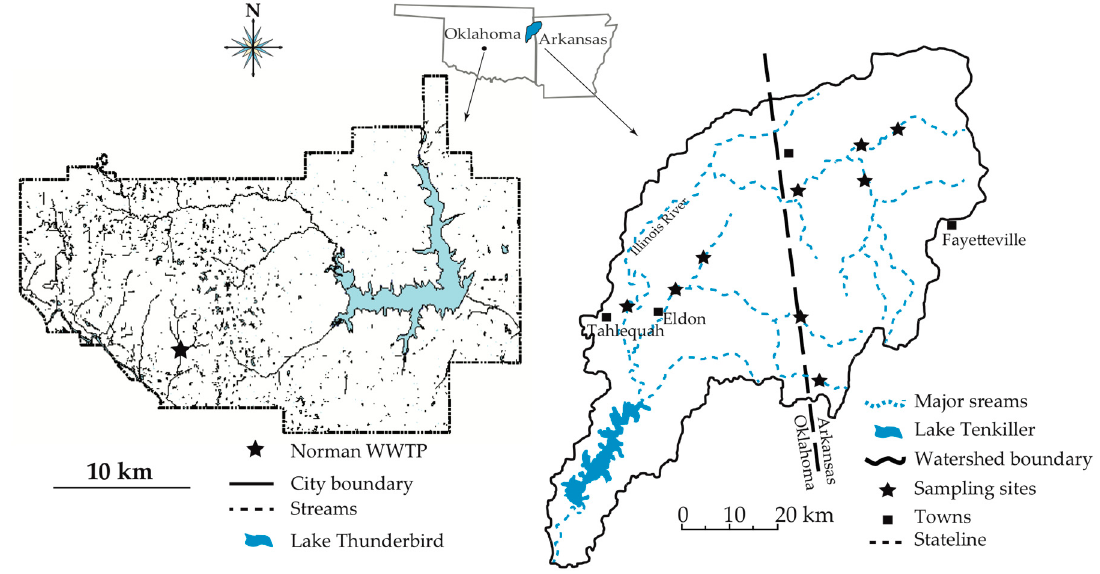
Figure 1. Map of the study area and sampling sites. ( Left ) The Norman WWTP, located in the center of Oklahoma; ( Right ) the Illinois River Basin, across the northeast of Oklahoma and northwest of Arkansas (Adapted from Biache and Philp [14]).